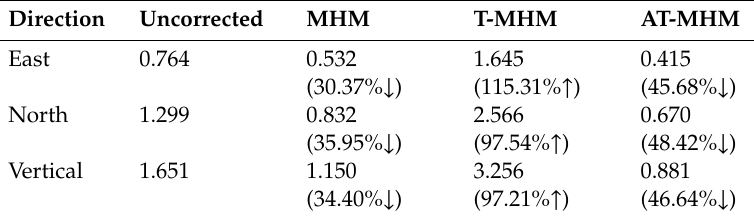
Figure 12. The comparison between the MHM and AT-MHM multipath correction results of the east ( left panel ) and north ( right panel ) directions on DOY52. X-axis unit: second, Y-axis unit: meter. Table 6. The RMSE of the uncorrected and MHM, T-MHM, and AT-MHM corrected solutions on DOY51. (Unit: meter).